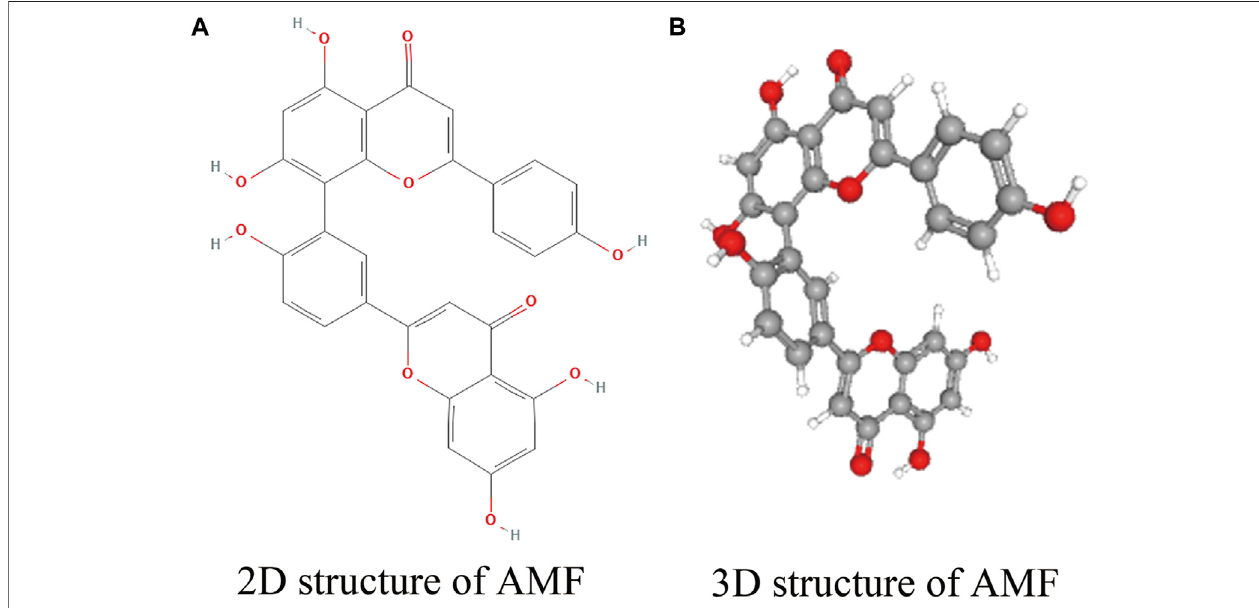
FIGURE 1 | Structure of AMF. (A) 2D structure of AMF; (B) 3D structure of AMF.